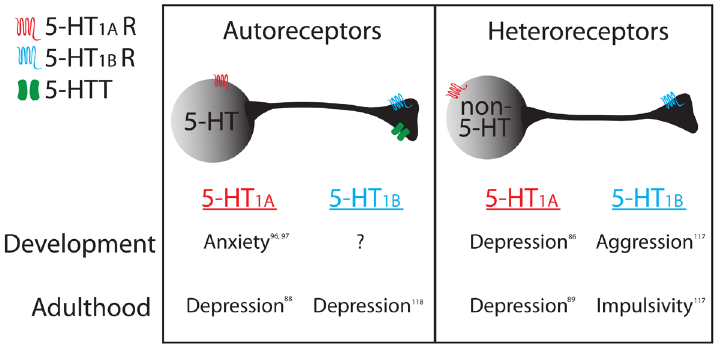
Figure 2. Diagram summarizing the roles of autoreceptor and heteroreceptor populations of serotonin (5-hydroxytryptamine, 5-HT) 1A (5-HT ) and 5-HT receptors on behavior during development and adulthood. 5-HTT, serotonin 1A 1B